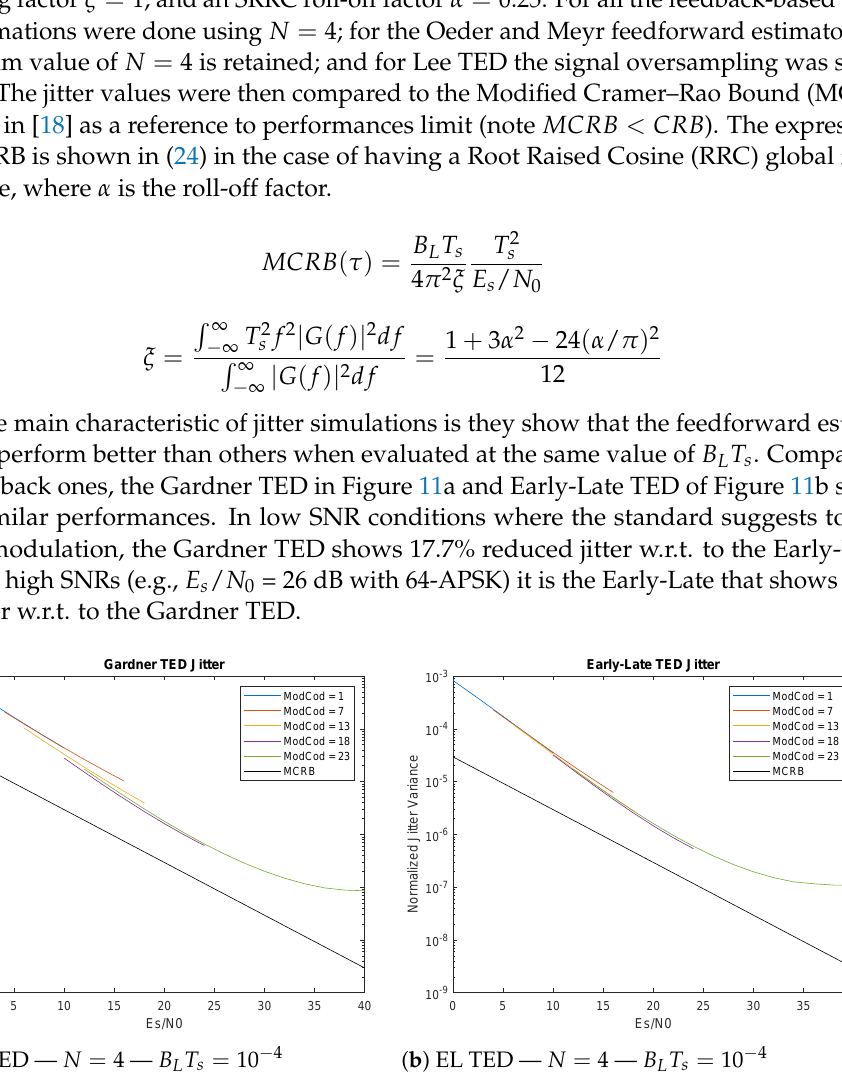
Figure 11. Gardner TED and Early-Late TED jitter evaluation (5 × 10 8 transmitted